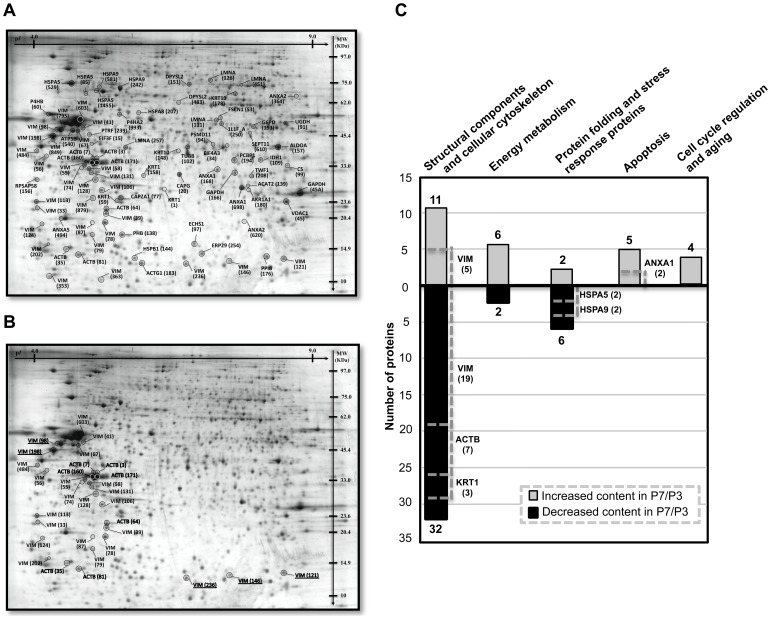
Differential protein expression of P3 and P7 cells.(A) 2-DE reference map of the human BM MSC obtained from Donor 1; (B) protein map showing the position of the 7 ACTB and of the 24 VIM isoforms showing a higher (underlined) or a lower content in P7 compared to P3; (C) functional categories with the highest number of proteins whose content is altered in P7 compared to P3. The number of protein isoforms is indicated.